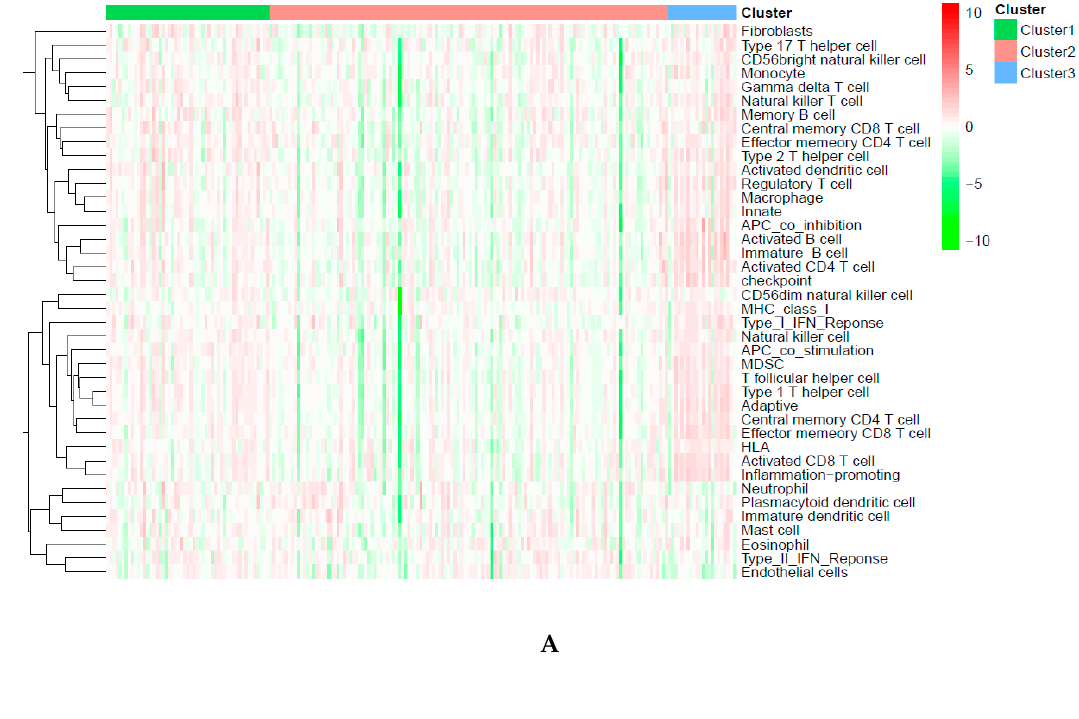
Figure 6. Classification according to CpGs-pair and clinicopathological features in the testing set is consistent with the training set and also different. ( A ) Heatmap of 441 CpGs-pairs. ( B ) PCA vali- dated the stability of the classification. ( C ) Methylation level of each subtype. ( D ) Gene expression level of each subtype. ( E ) Overall survival curve for each DNA CpGs-pair subtype. ( F – L ) Clinico- pathological features among each DNA CpGs-pair subtype.